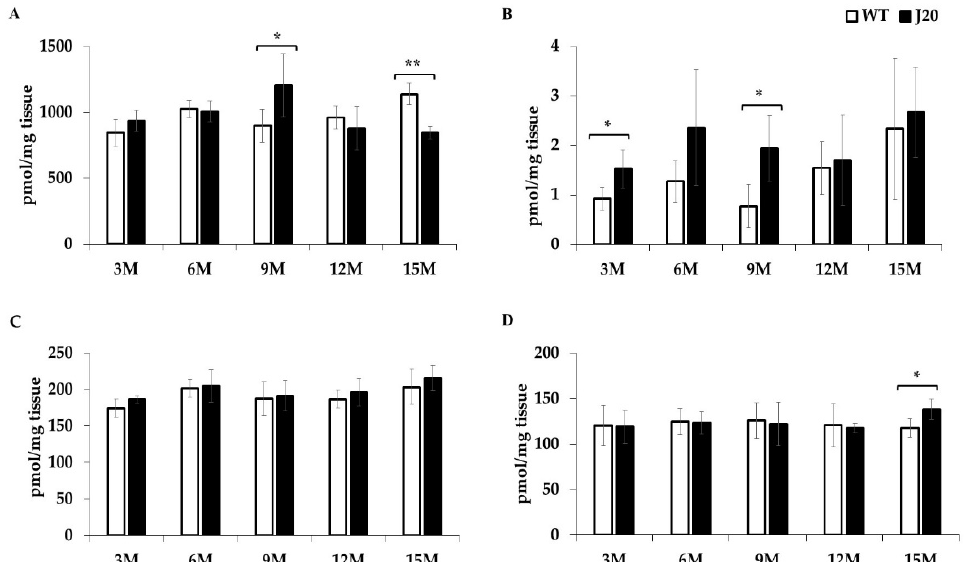
Figure 1. Time-dependent change of total Pls-PE, alkyl-acyl-PE, Pls-PC, and alkyl-acyl-PC in the hippocampus of J20 and WT mice. The concentration of total Pls-PE, alkyl-acyl-PE, Pls-PC, and alkyl-acyl-PC was measured by LC-SRM/MS, as described in the Materials and Methods. The changes of total Pls-PE ( A ), alkyl-acyl-PE ( B ), Pls-PC ( C ), and alkyl-acyl-PC ( D ) were shown. The data are presented here as means ± SD of four mice in a group. Statistical significance is denoted as follows: * p < 0.05, ** p < 0.01 vs. wild-type mice of the same age. M indicates months. Next, multivariate analyses, including OPLS-DA and PCA, were done to check the dis- tribution pattern of Pls-PE, alkyl-acyl-PE, Pls-PC, and alkyl-acyl-PC metabolism in the J20 and WT littermate mice. For Pls-PE species, the OPLS-DA score plot clearly separated the J20 and WT mice groups at all time points. However, PCA analysis could separate J20 and WT mice only at 9 and 15 months. The first principal component effectively and distinctly separated the J20 and WT groups at 9 and 15 months (Figure 2). For Pls-PC and alkyl-acyl- PC, the OPLS-DA score plot separated J20 and WT mice groups. In the PCA analysis, the first principal component could not separate effectively at any time point (Figures S1 and S2).